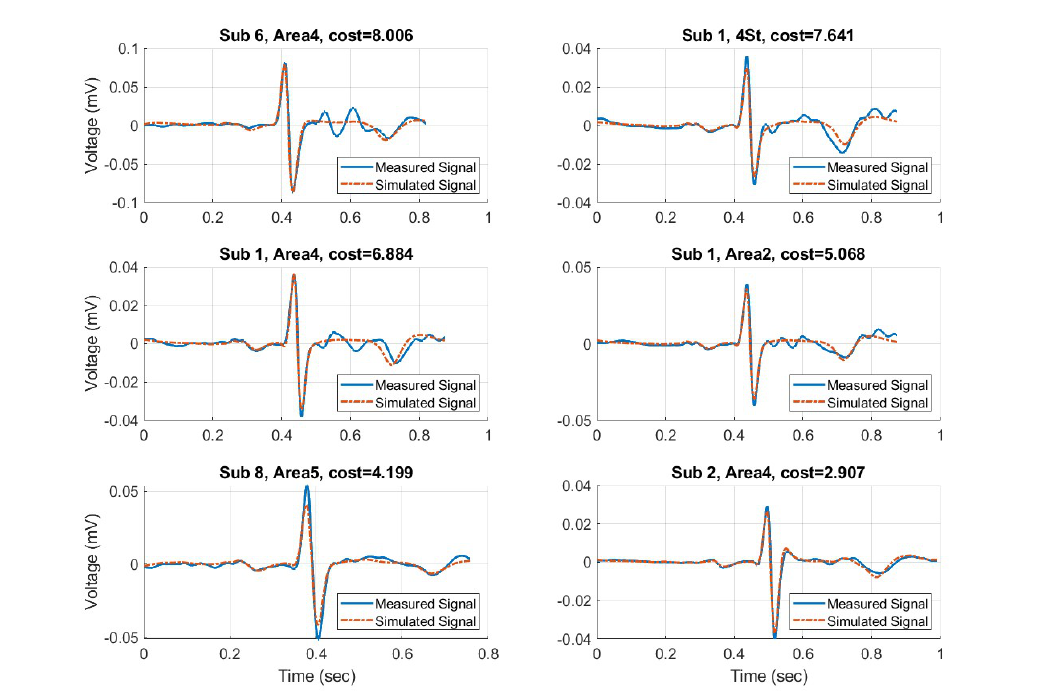
Figure 11. The 6 best fit simulated waveforms with their corresponding measured